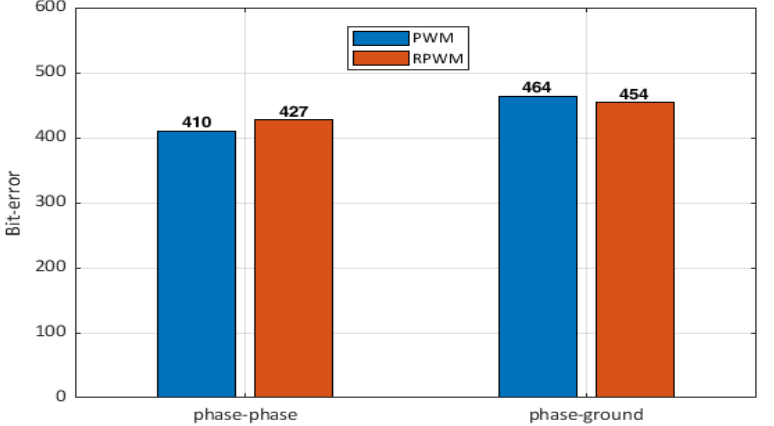
Figure 15. Bit error rate with coupling/decoupling networks connected between two phases or between one phase and ground (10 kHz switching